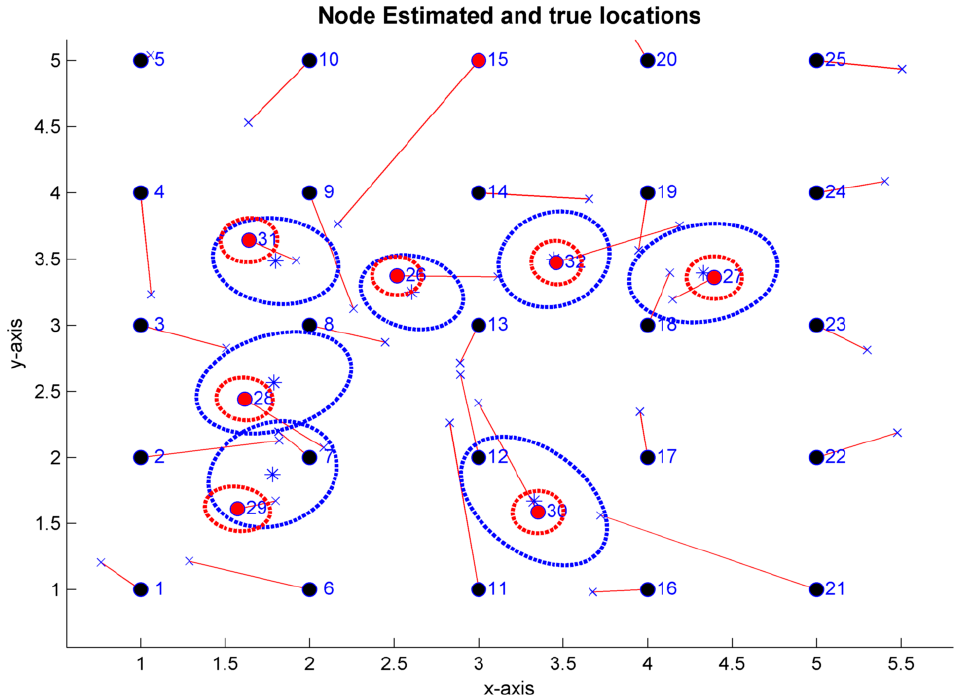
Figure 12. Estimator 1 − 𝜎 uncertainty ellipses ( ) and CRLB-TOA on the 1 − σ uncertainty ellipses ( ). 𝑅 = 1.5 m, 𝑠𝑡𝑑(TOA) = 0.5 m .